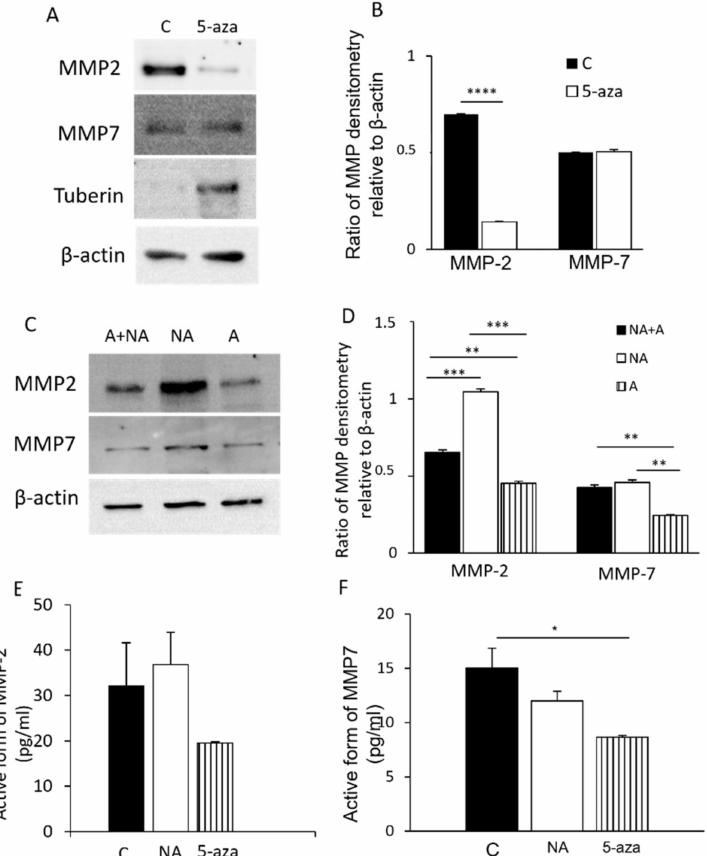
Figure 1. Tuberin expression and adhesion control of MMP-2 and MMP-7 levels in LAM/TSC cells: ( A ) Representative images of Western blot for MMP-2 and MMP-7 following incubation of 5-azacytidine (5-aza-1 µ M) for 96 h to induce tuberin expression. Tuberin expression was tested. β -actin was used as an internal reference of total protein. ( B ) Relative intensity by densitometric analysis was evaluated relatively to β -actin levels. The data are presented as mean ± SEM, n = 3 experiments. **** p < 0.0001 compared to C (Student T-test). ( C ) MMP-2 and MMP-7 levels were analyzed in adherent ( A ), nonadherent (NA), and N + NA conditions, and representative images are shown. β -actin was used as an internal reference of total protein. ( D ) Relative intensity by densitometric analysis was evaluated relatively to β -actin levels. ( E ) MMP-2 and ( F ) MMP-7 activity was analyzed by using a QuickZyme assay in control cells ( C ), NA cells, and in cells treated with 5-azacytidine ( n = 3 experiments). For ( D – F ) statistical analysis was performed with ANOVA with Tukey test ± SEM ( n = 3 experiments) * p < 0.05; ** p < 0.01; *** p < 0.001; **** p <